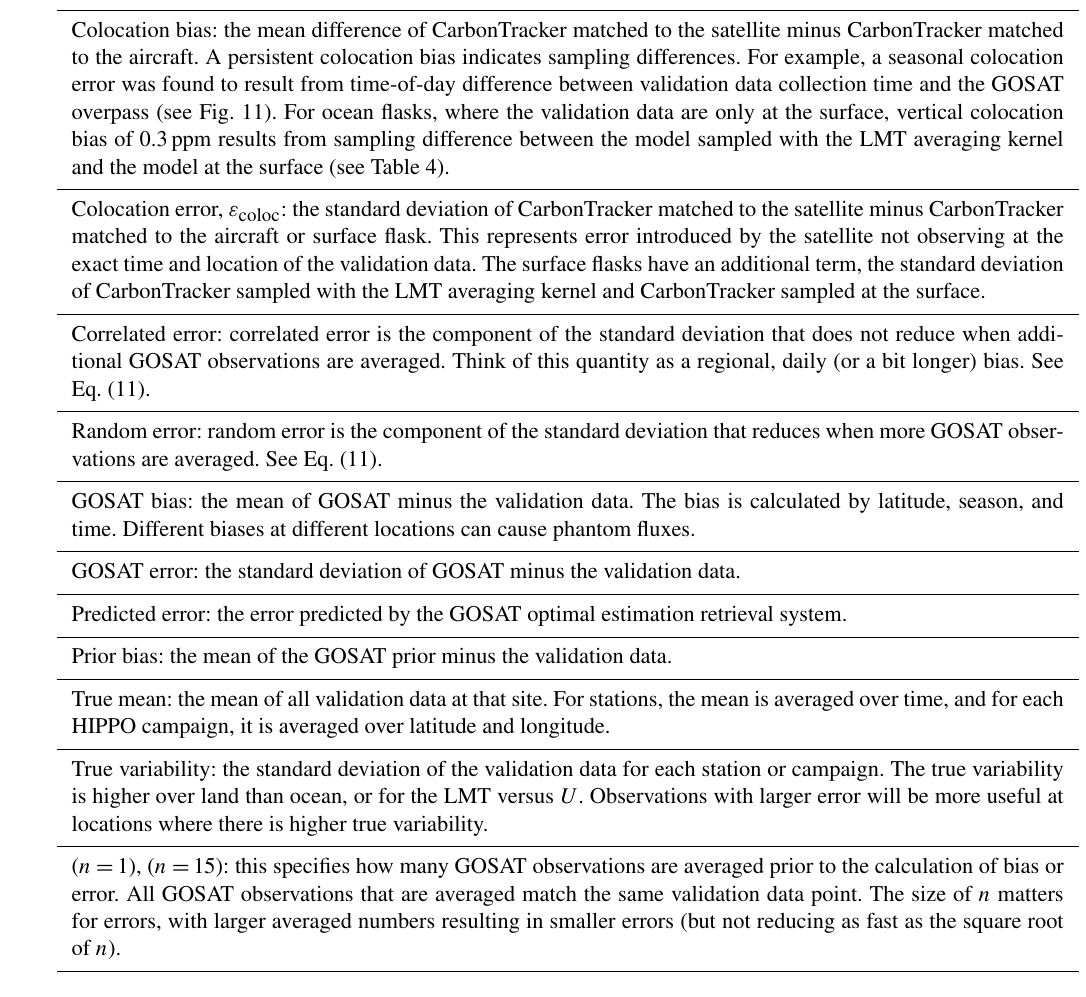
Table 3. Definition of comparison